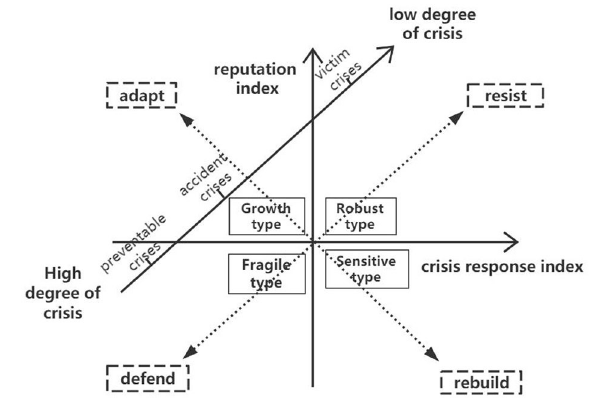
Figure 3 is composed of MHI reputation positioning types, reputation management strategies, and crisis scenario